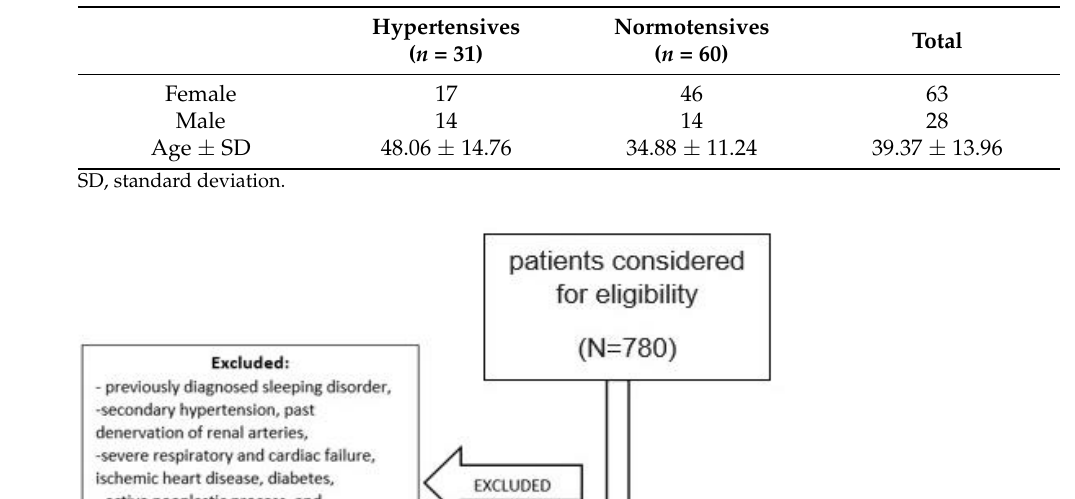
Table 1. Characteristics of the study group ( n = 91).